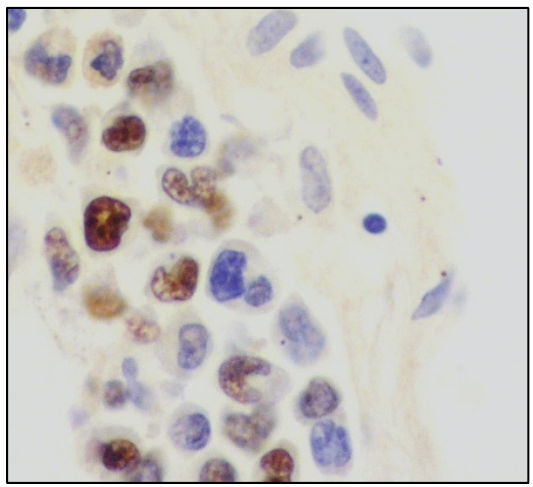
Figure 5. High-power view showing lung parenchyma with EBER-positive atypical cells within vascu-